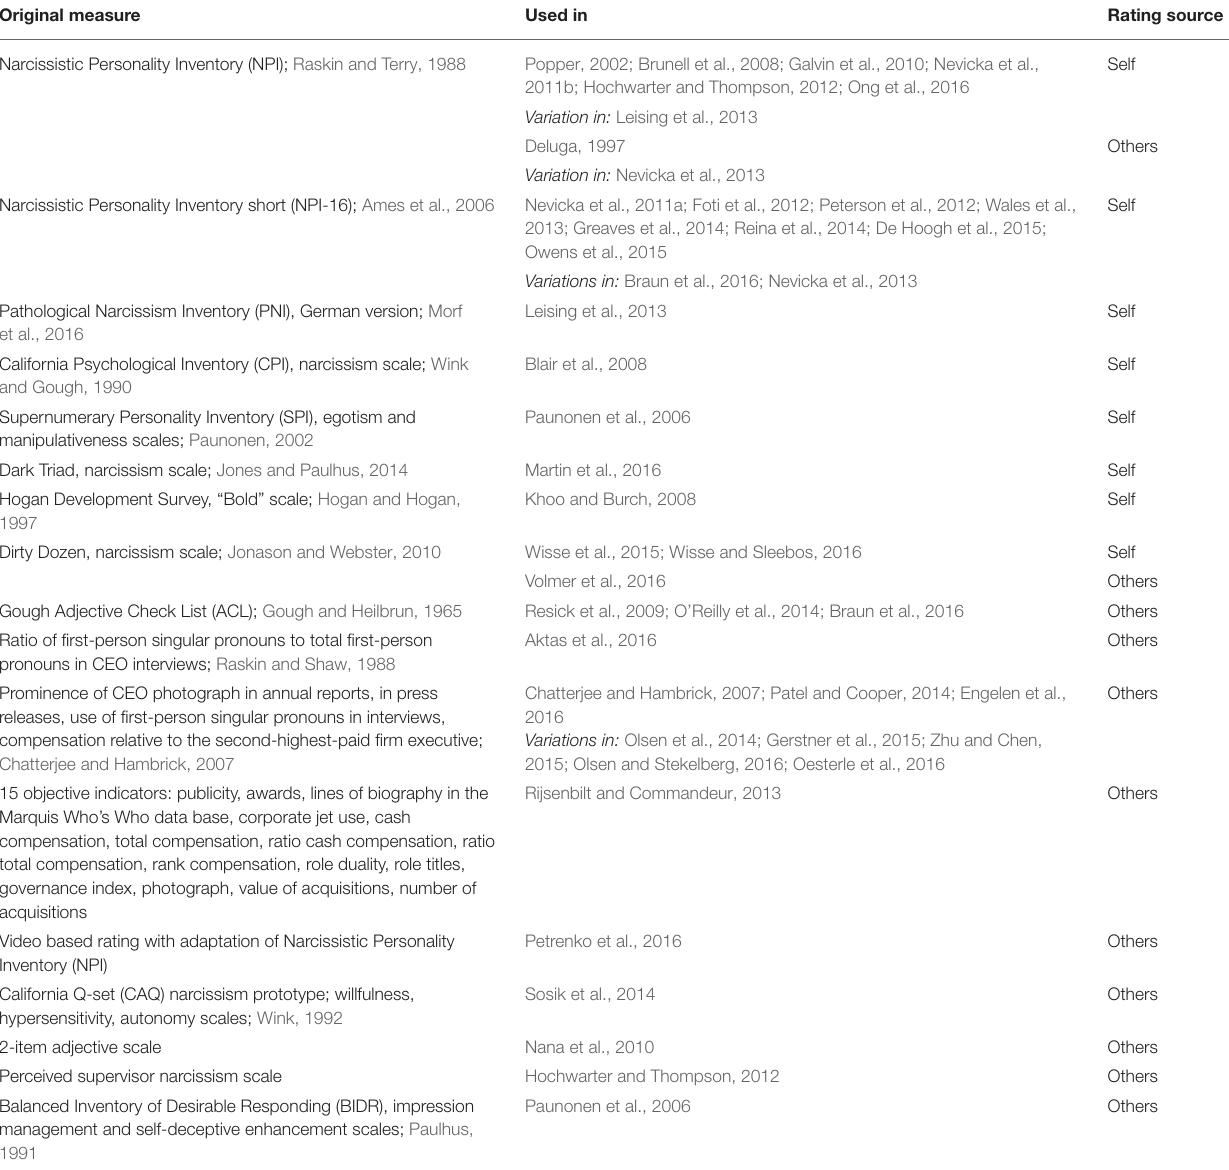
TABLE 2 | Quantitative measures of leader